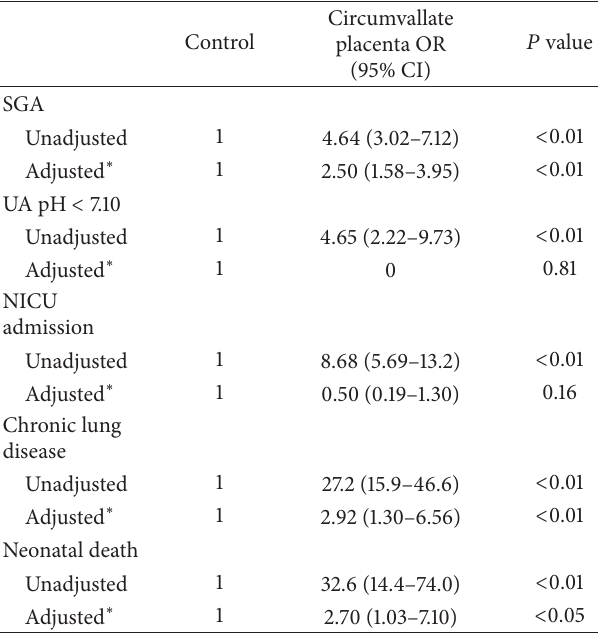
Table 3: Comparison of unadjusted and adjusted neonatal out- comes between circumvallate placenta and control groups.